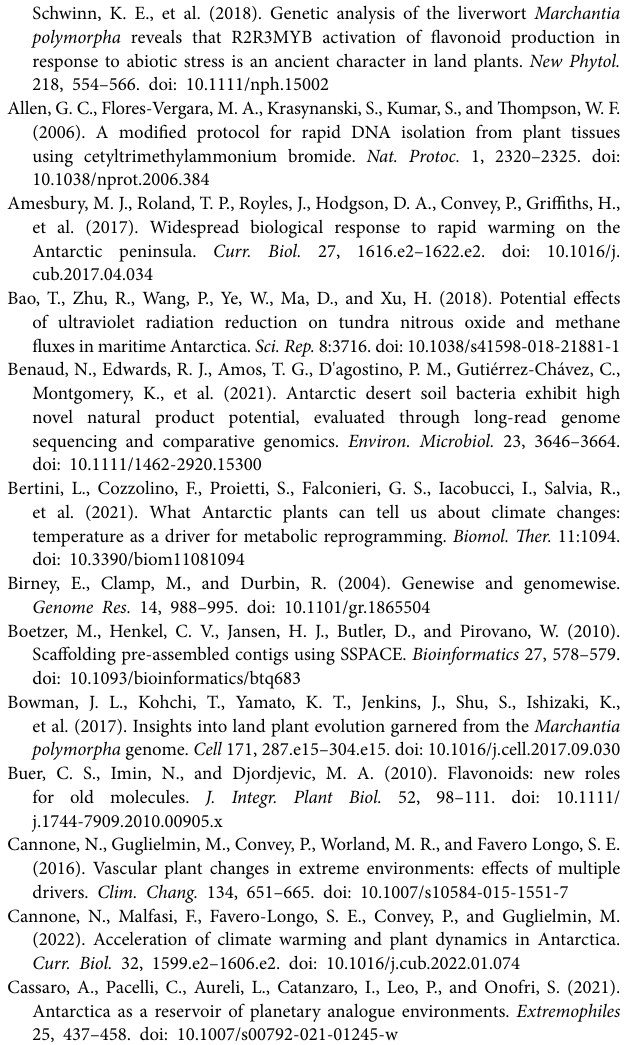
(D) Compare the consistency of syntenic blocks between two groups of P. nutans vs. C. purpureus , and P. nutans vs. P. patens . Supplementary Figure 3 | Venn diagram of gene families and clustering statistics. (A) The Venn diagram shows the shared and unique gene families in Pohlia nutans , Physcomitrella patens , Anthoceros angustus , and Klebsormidium nitens genomes. (B) The Venn diagram shows the shared and unique gene families in P. nutans , P. patens , A. angustus , K. nitens , and Chlamydomonas reinhardtii genomes. (C) Scatterplot of KEGG enrichment of the unique family genes in P. nutans . (D) Clustering statistics of gene family among the green plants of different evolutionary status. Supplementary Figure 4 | Phenylalanine ammonia-lyase (PAL) family was expanded and upregulated under various abiotic stresses. (A) Phylogenetic analysis of PAL families in five bryophyte species ( Pohlia nutans , Physcomitrella patens , Marchantia polymorpha , and Anthoceros angustus ). The branches of P. nutans were colored in red, and the gene ID of P. nutans were shown. (B) Heatmap showed that PAL genes were markedly upregulated under cold stress, and UV-B radiation detected by transcriptome sequencing.